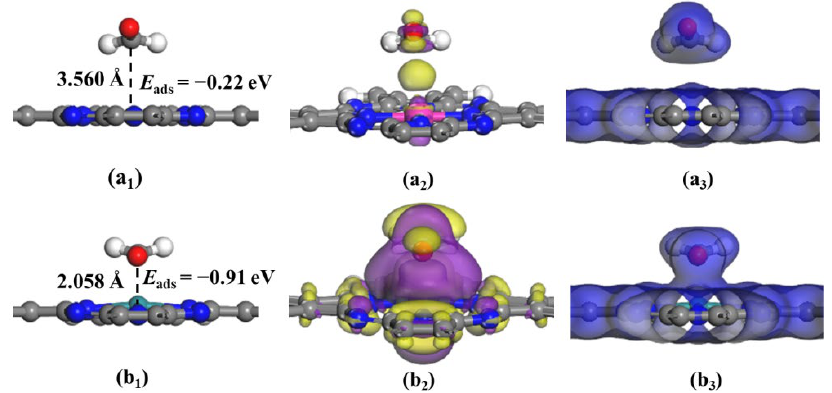
Figure 5. Lowest-energy structures, charge-density difference (CDD), and electron-density distribution (EDD) of CH 2 O adsorbed on PdPc and RuPc monolayers. ( a 1 – a 3 ) represent the CH 2 O@PdPc adsorption system and ( b 1 – b 3 ) represent the CH 2 O@RuPc adsorption system. The yellow (purple) region represents electron accumulation (depletion), and the isosurface of CDD and EDD is ± 0.005 e/Å 3 and 0.2 e/Å 3 , respectively.